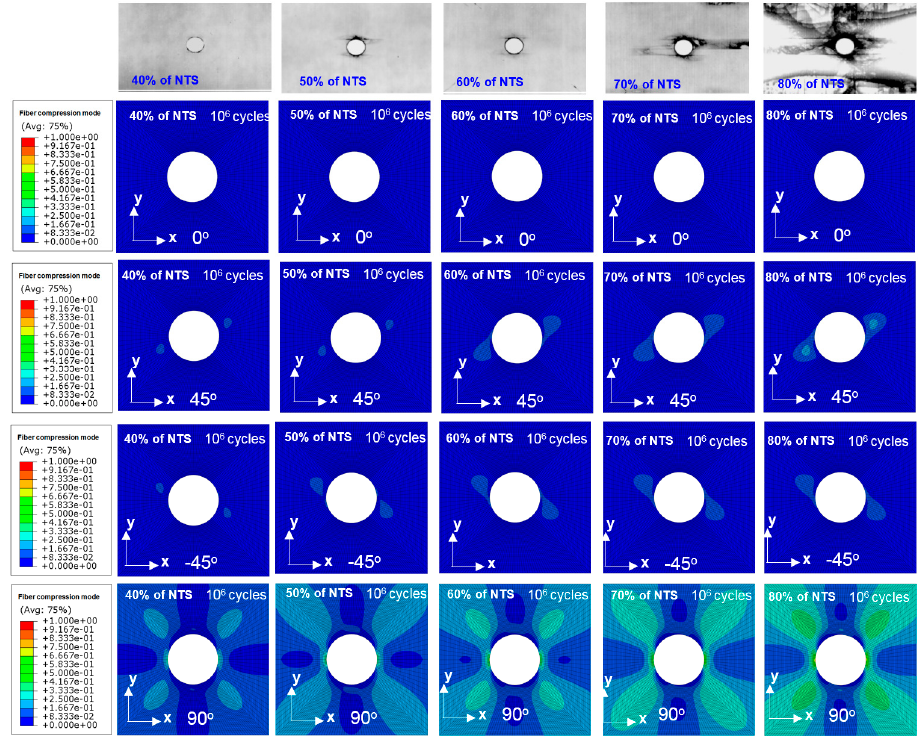
Figure 11. Fiber compression failure index after 10 6 cycles in the quasi-isotropic OHT specimen.